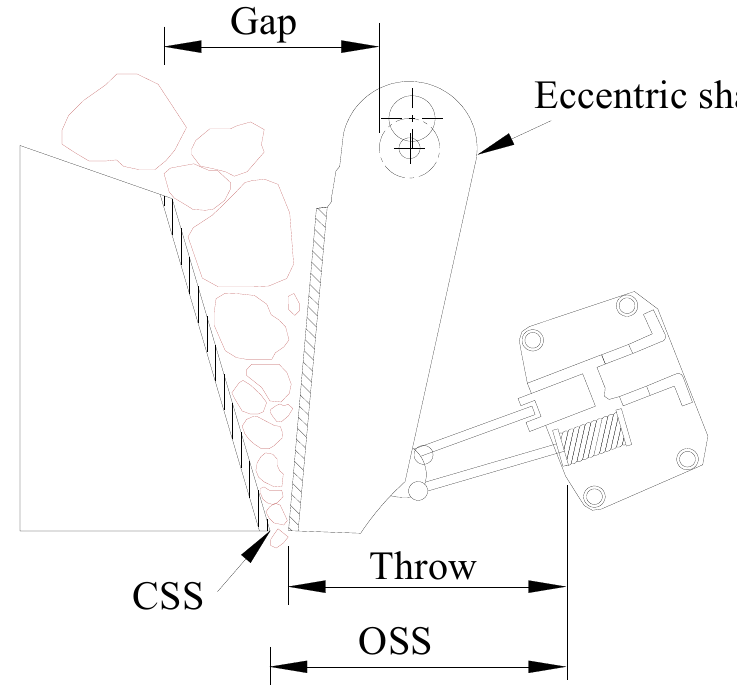
Figure 1. Kinematic of a single jaw crusher [3] .